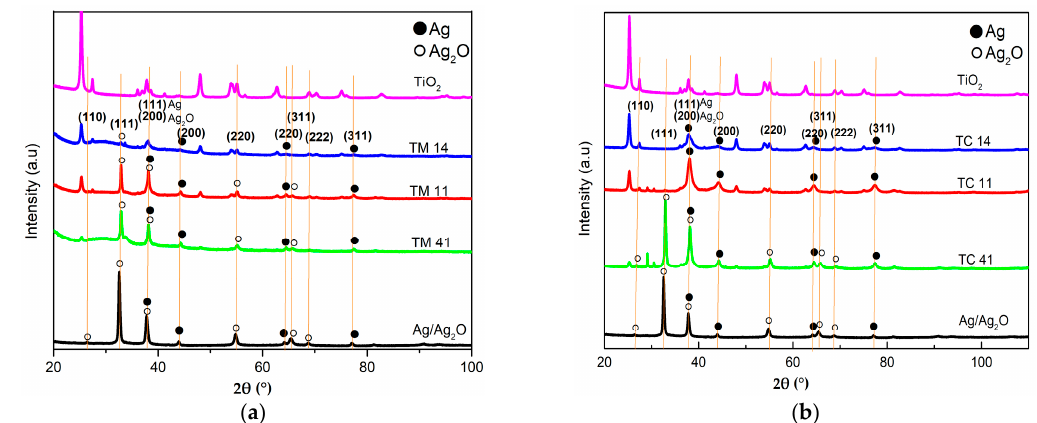
Figure 1. X-ray diffraction (XRD) patterns of ( a ) TiO 2 containing mixtures (TM), and ( b ) TiO 2 containing composites (TC). The diffractograms of Ag/Ag 2 O and TiO 2 are included in both figures. 2 θ °